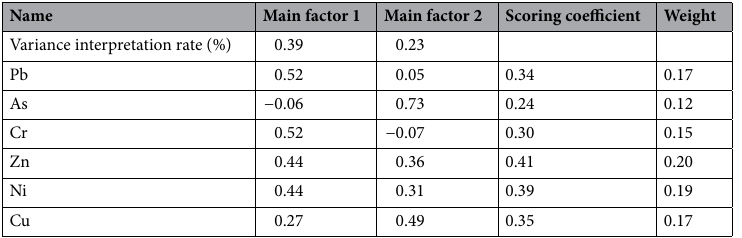
Table 4. Linear combination coefficients and weight